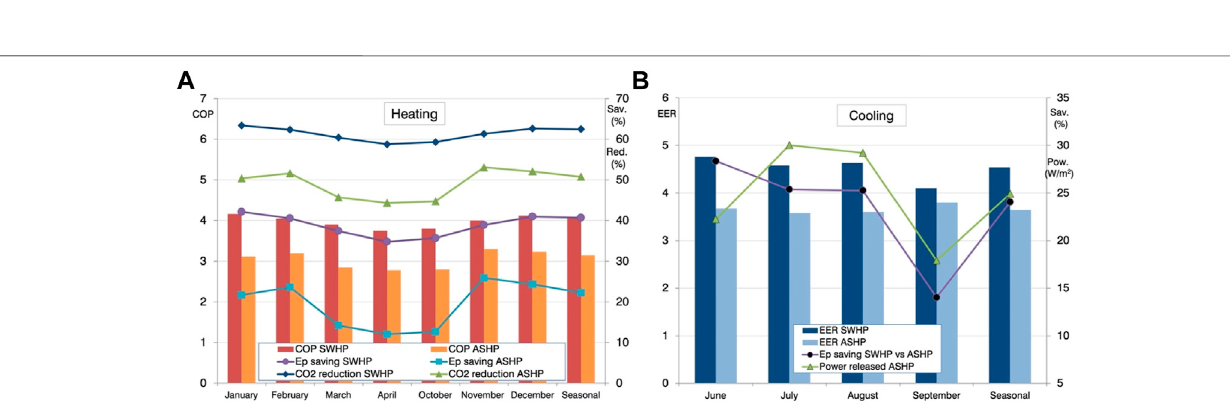
Frontiers in Energy Research |